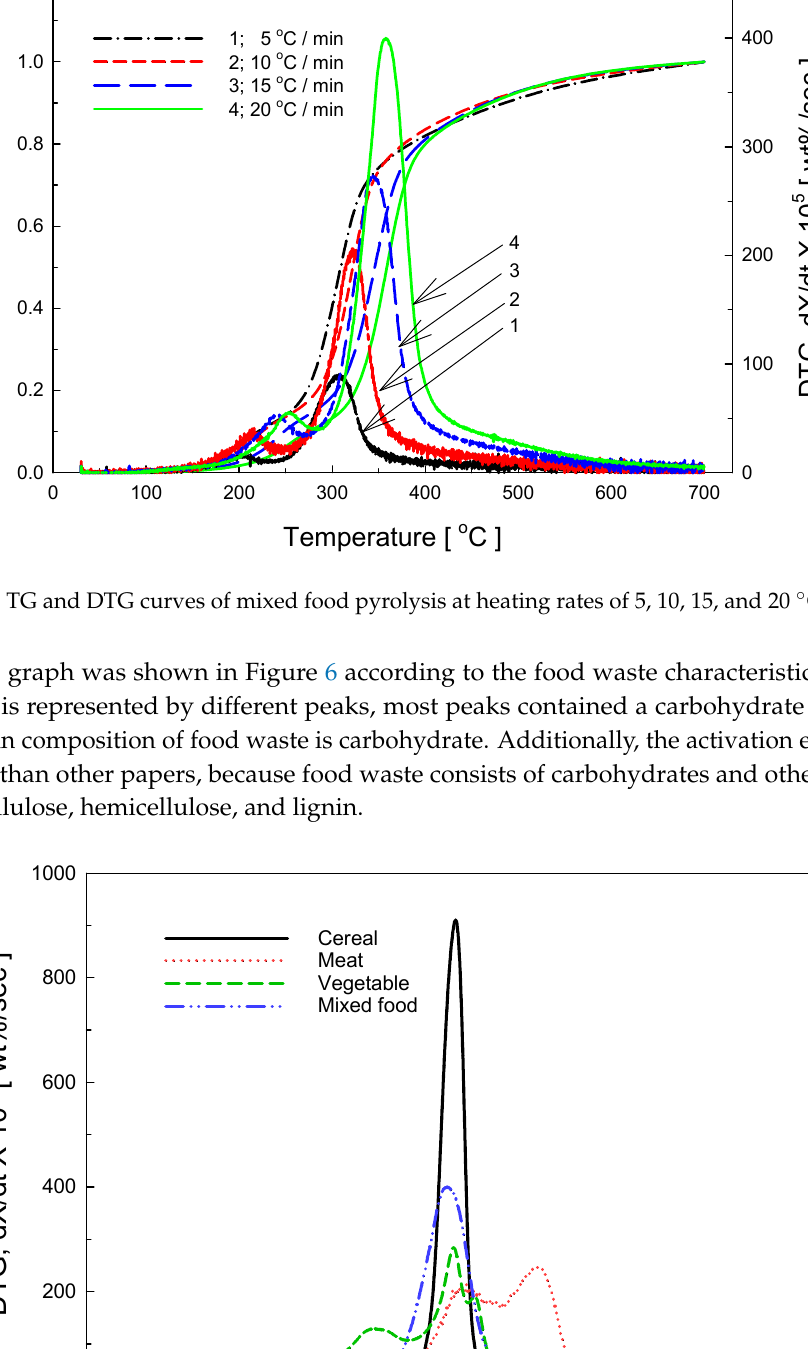
Figure 4. TG and DTG curves of vegetable pyrolysis at heating rates of 5, 10, 15, and 20 °C/min.